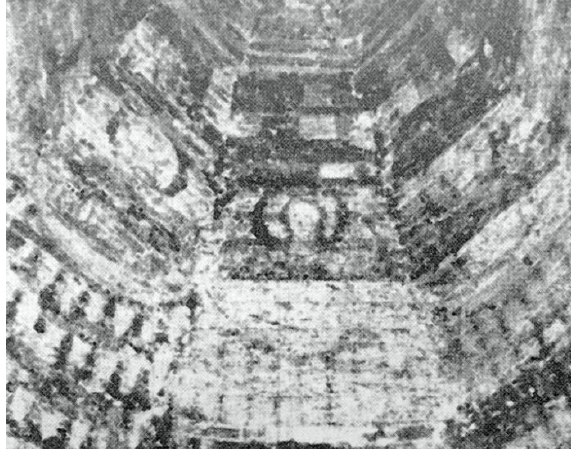
Figure 5. Wide viewing angle archival image (Burresi & Caleca, 2003).